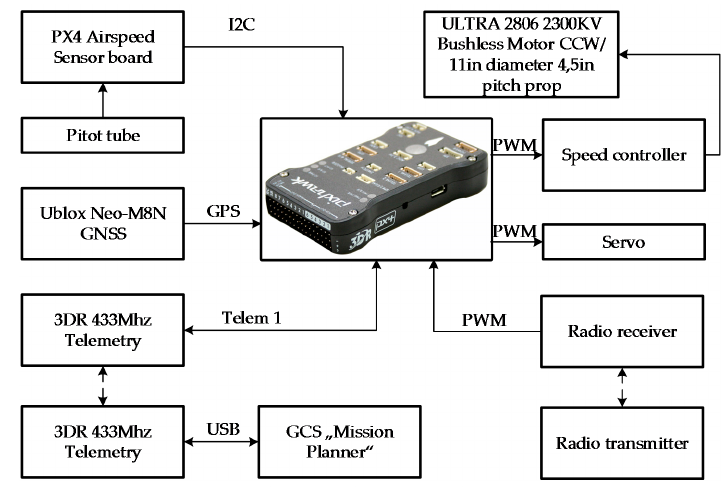
Figure 8. Research UAV: ( a ) Manufactured UAV; ( b ) UAV prototype in “Solidworks”.